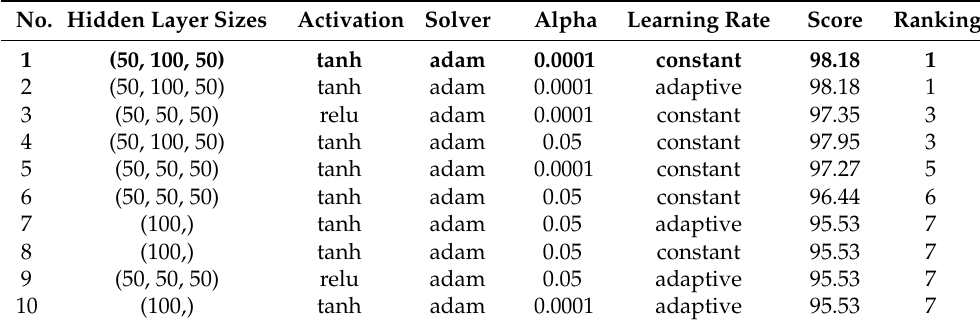
Table 9. Multilayer Perceptron hyperparameter-tuning results.